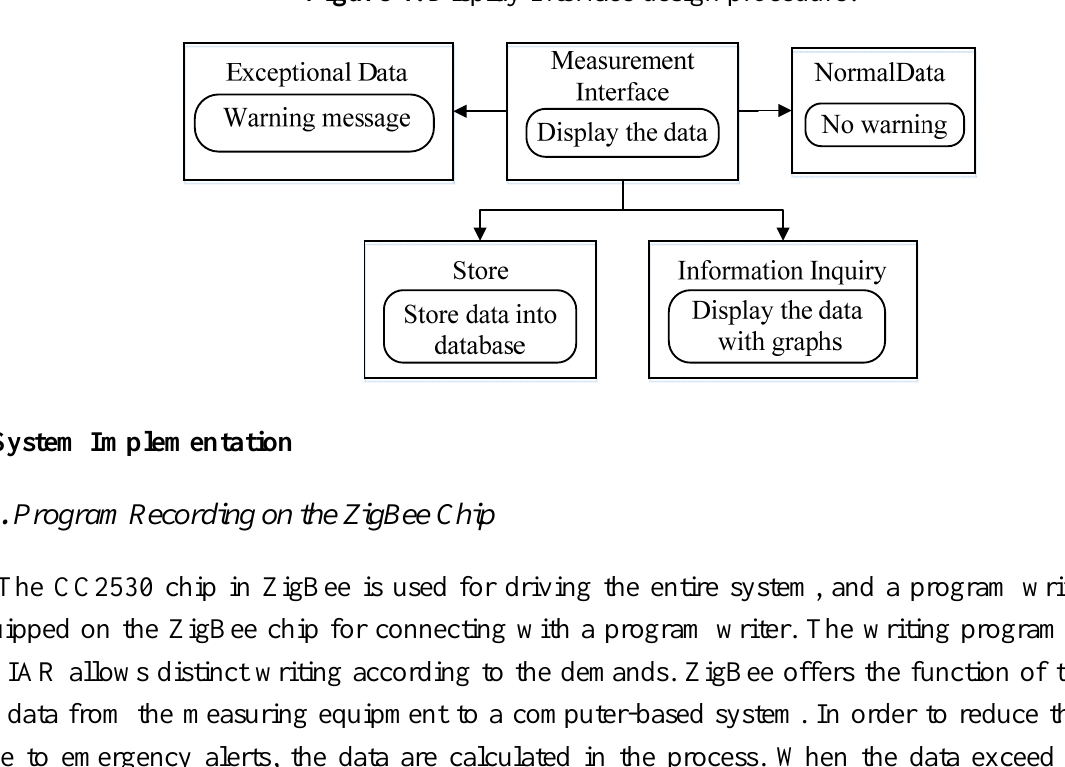
Figure 4. Display interface design